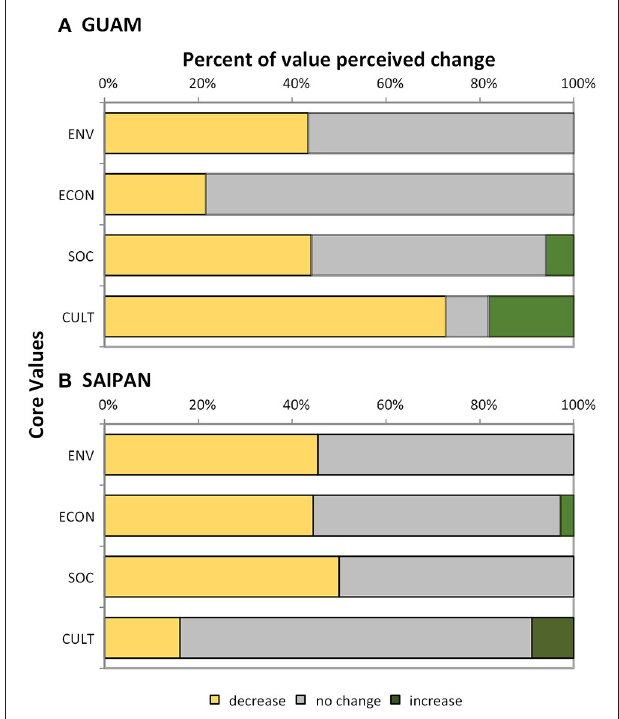
FIGURE 5 | Respondents’ perceived change in core value worth after a non-native marine species arrived in their country for: (A) Guam; and (B) Saipan. Where green, increase in worth; gray, no change (neutral); and orange, decrease in